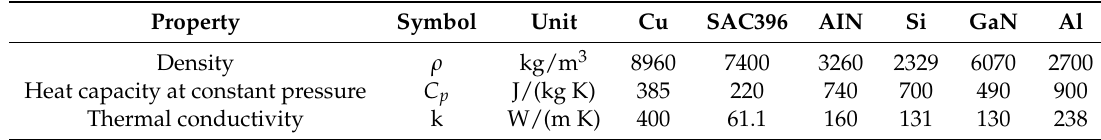
Table 6. Thermal properties of materials